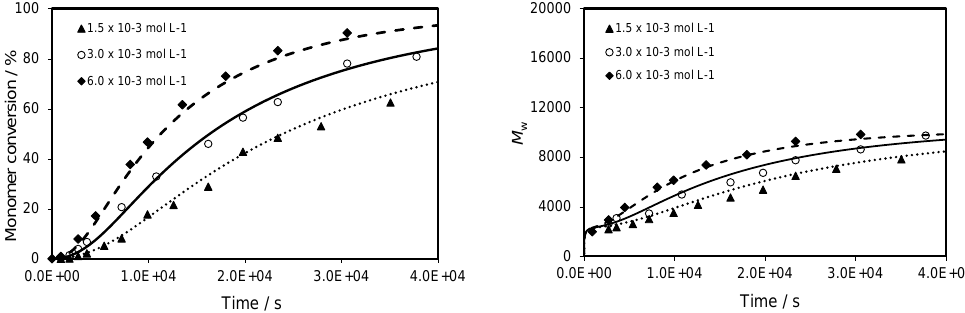
Figure 7. Evolution of monomer conversion and M w versus reaction time for CPDB-mediated polymerization of TBDMSMA in toluene at 70 °C with initial concentration of AIBN ranging from 1.5 × 10 −3 to 6.0 × 10 −3 mol·L −1 . The graph compares predicted values (lines) with experimental data (points).